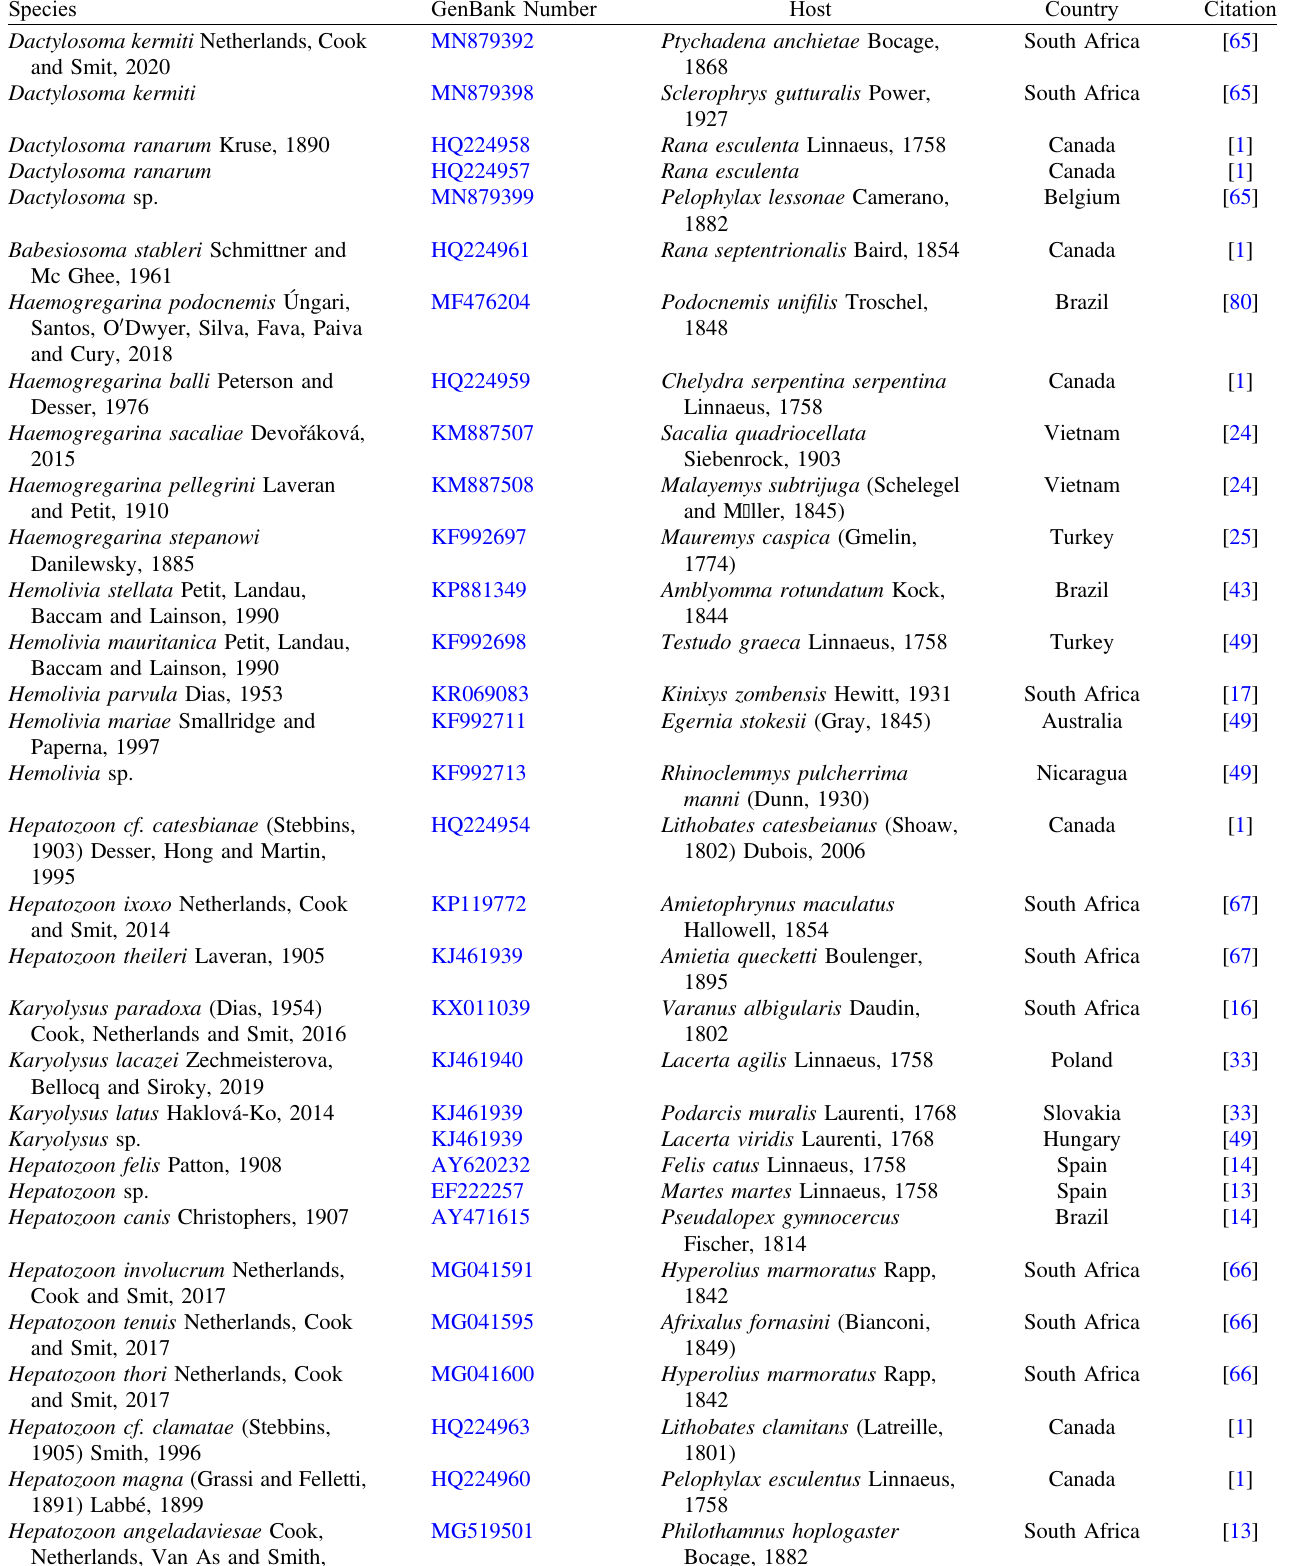
Table 2. GenBank accession numbers, hosts, country and citation for SSU rDNA sequences of haemogregarines from reptiles, amphibians and mammal used in the phylogenetic analyses (except the sequence from this